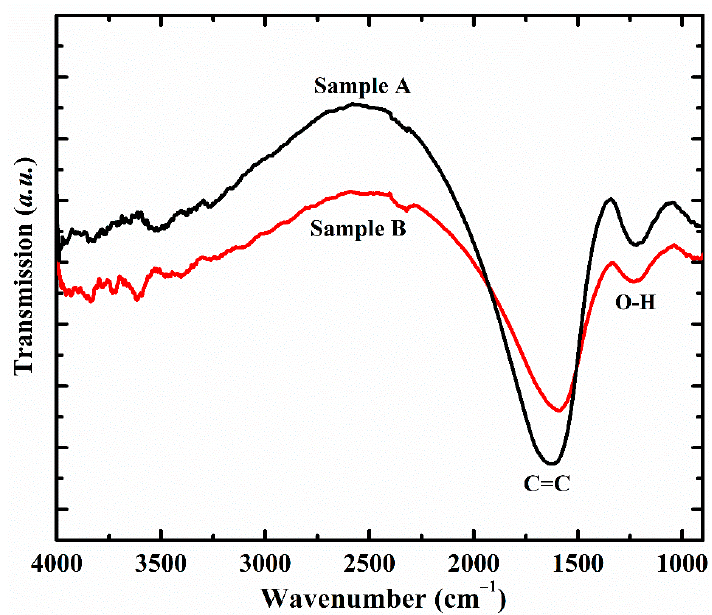
Figure 4. FTIR spectra of synthesized graphene samples.